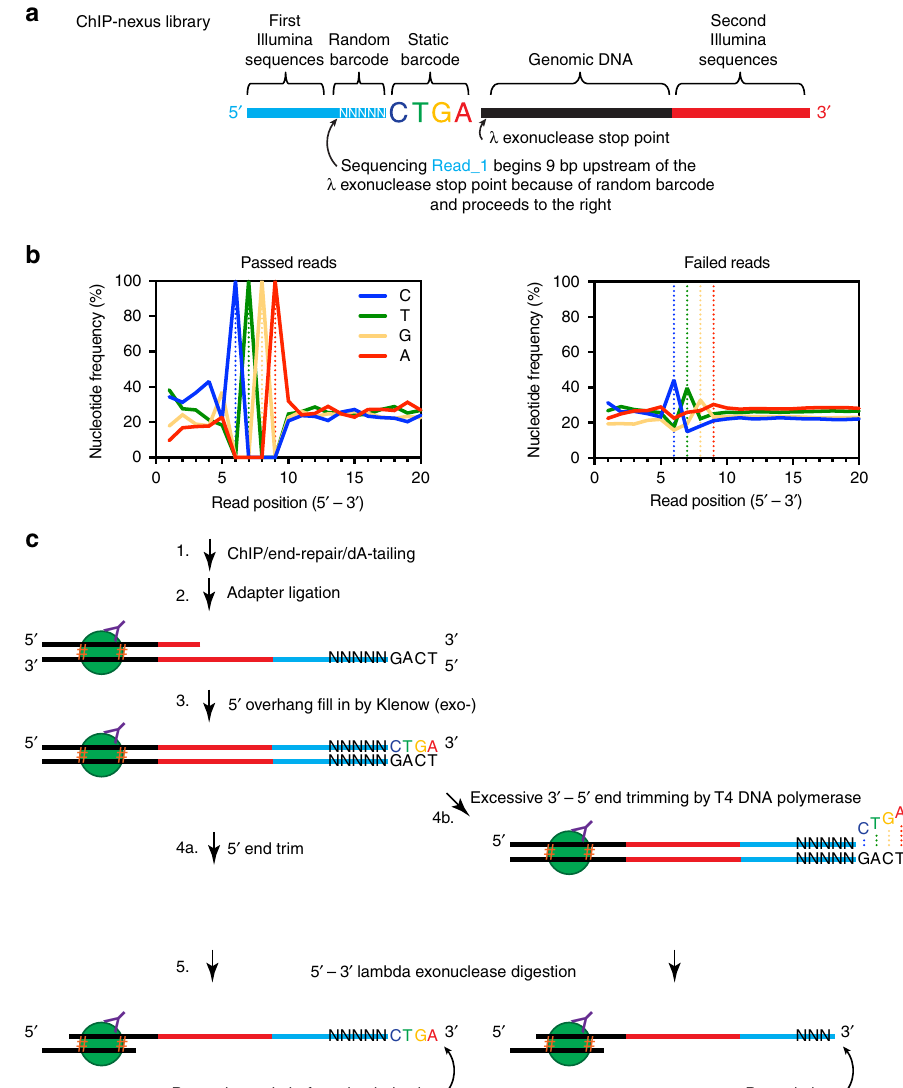
Fig. 1 Evaluation of ChIP-nexus data. a Schematic of a completed ChIP-Nexus DNA library. b Nucleotide frequency at the 5 ′ end of the sequencing tags among tags that pass (left) or fail (right) the computational fi lter as de fi ned previously 9 . c Proposed explanation for the pattern of nucleotide frequency observed in tags that fail to pass fi lter. Desired end-trimming produces blunt-end DNA as shown in steps 3 and 4a. Excessive trimming will produce a 5 ′ overhang in step 4b that would result in the pattern at the sequenced tag seen in ( b ). Orange hashtags represent protein-DNA